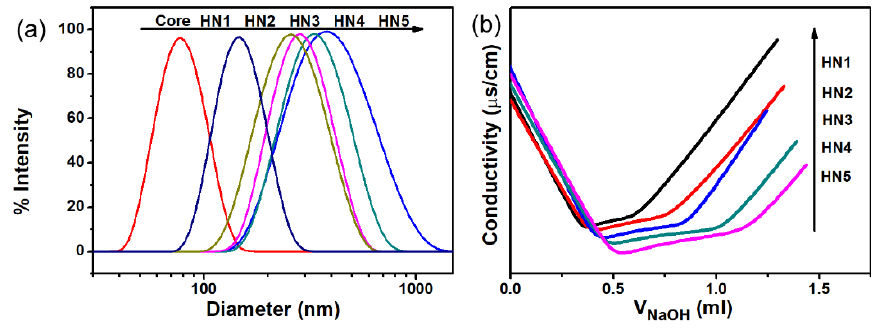
Figure 3. ( a ) DLS of HNs; ( b ) conductivity of HNs.